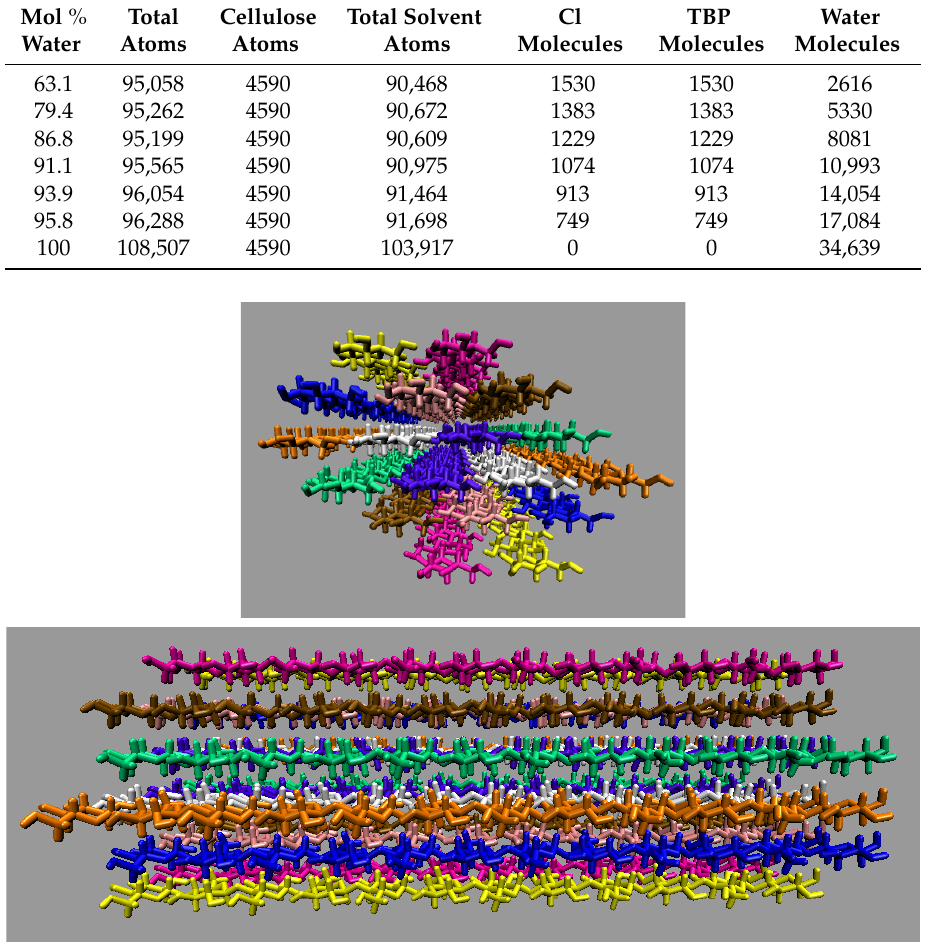
Figure 4. The initial configuration of the small I β cellulose bundle constructed via Cellulose-Builder [25]. The cellulose bundle has 18 individual strands with 12 glycan units per strand. The mirror image cellulose strands are identified using the same color